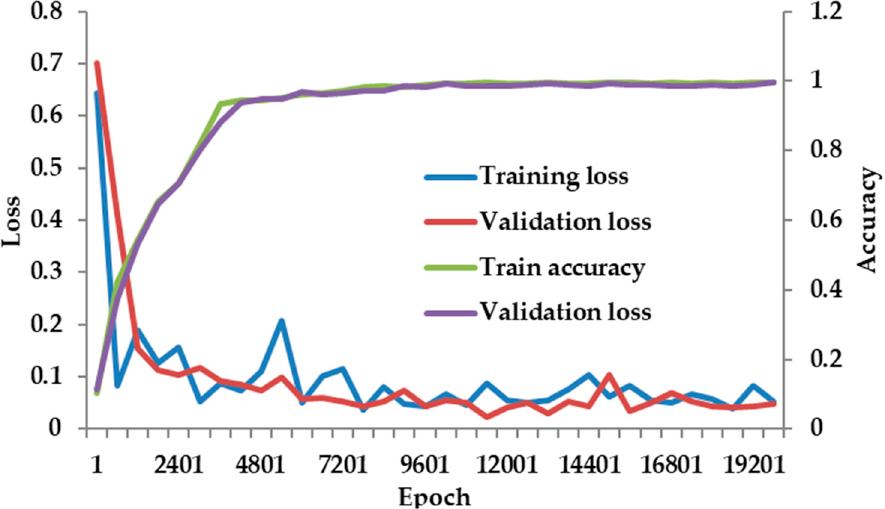
Figure 15. Training process.